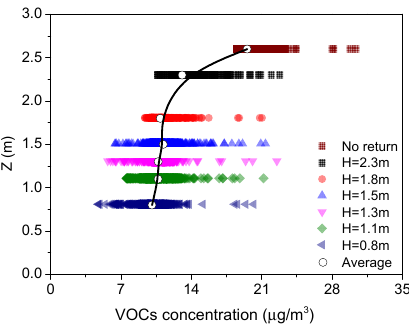
Figure 14. Comparison of frequency distribution of VOCs concentration for seven settings at breathing level (Plane Z = 1.0).